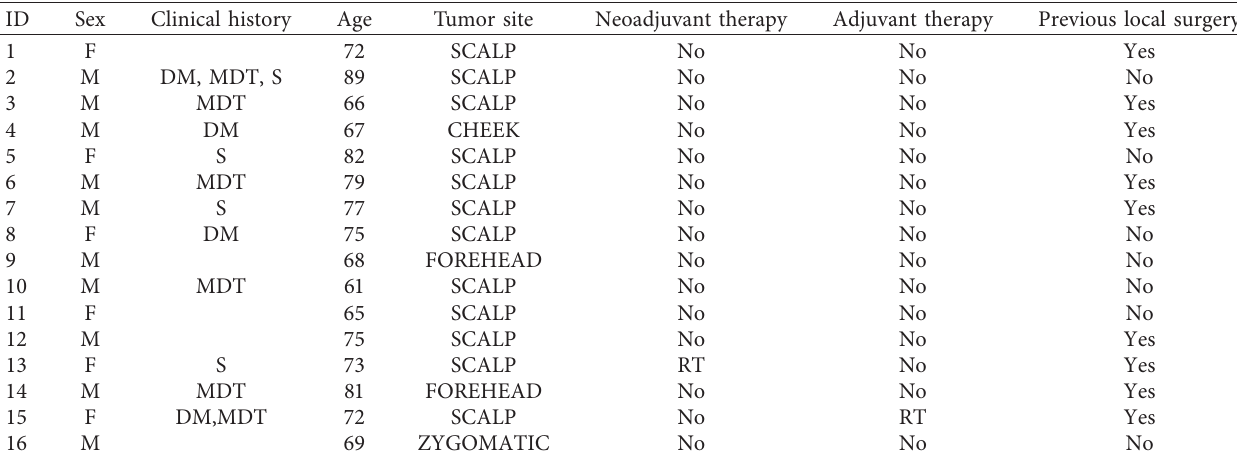
Table 2: Postoperative data